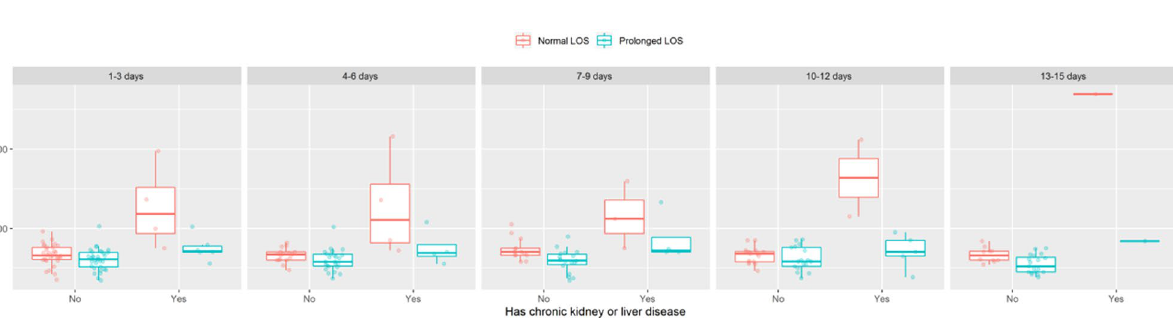
Figure 1. Creatinine level during hospitalization period until 15